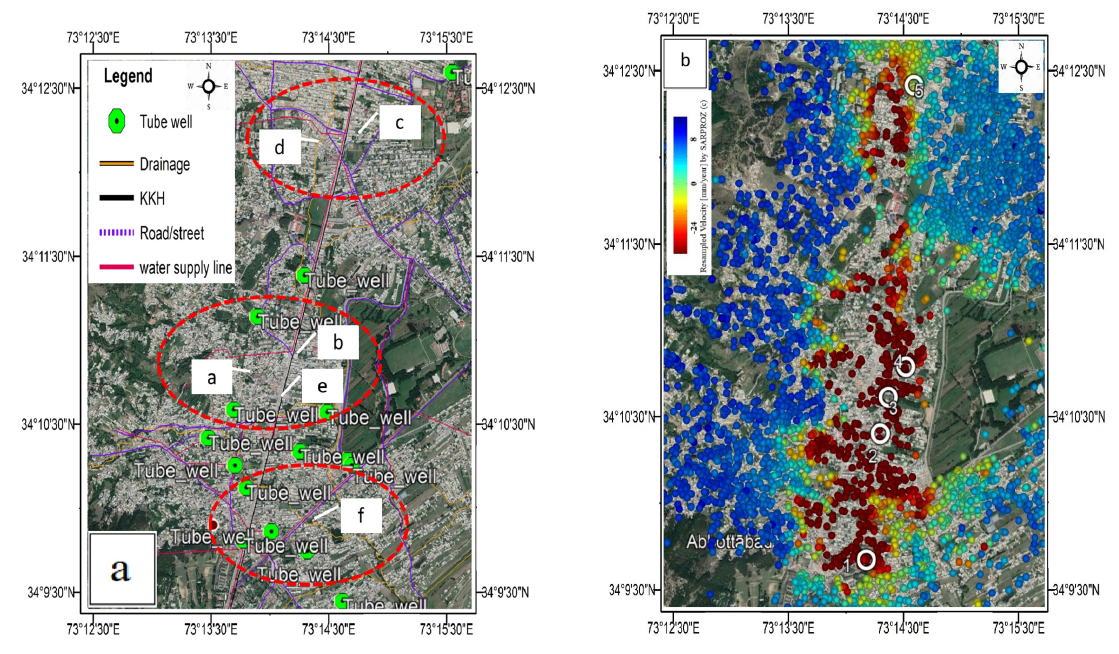
Figure 13. ( a ) Tube-well location map; ( b ) subsidence map (2017–2019).